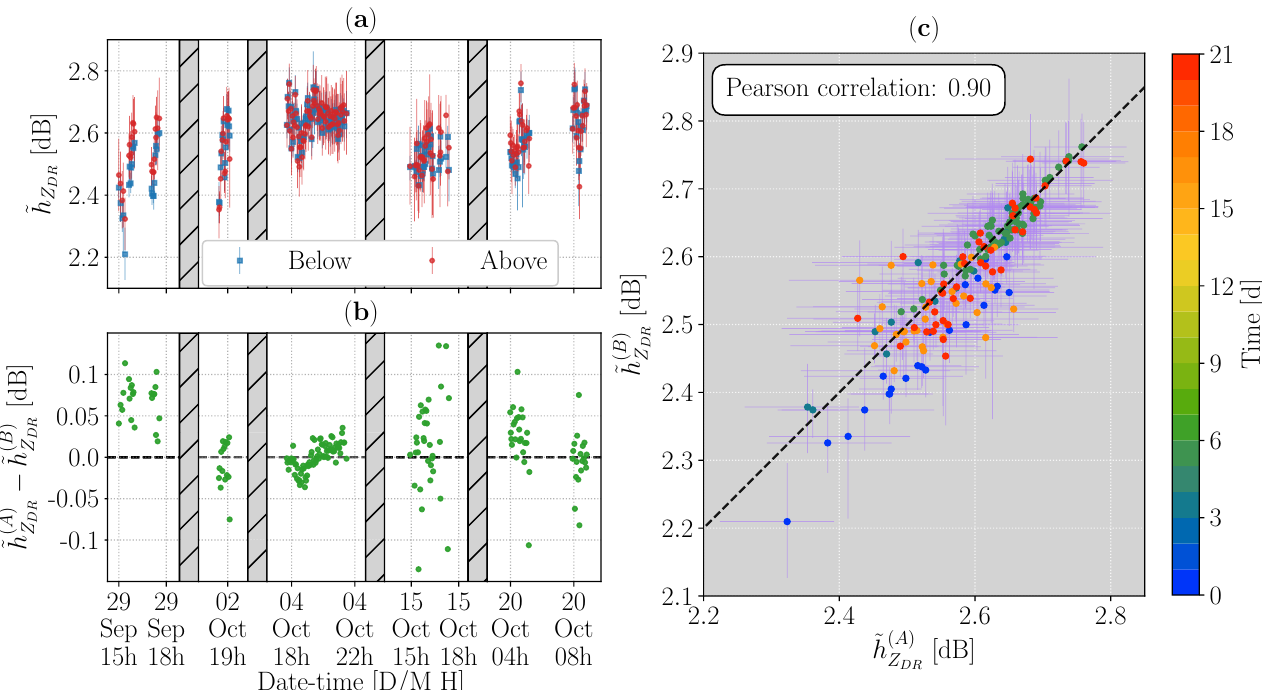
Figure 3. Comparison of median differential reflectivity values below and above the melting layer for the HYMEX campaign. ( B ) ( t ) (in blue) and ˜ h ( A ) ( t ) (in red), covering 5 precipitation events. The vertical bars around each ( a ) Time series of ˜ h i , u i , u Z DR Z DR dot represent the interquartile range of the distribution of Z DR values in the selected region of the scan. ( b ) Difference ˜ h ( A ) ˜ h ( B ) ( t ) ( t ) . The x-axis is shared with panel ( a ); ( c ) Scatterplot of ˜ h ( A ) i , u i , u Z DR Z DR − and horizontal bars representing the same interquantile range depicted in panel ( a ). The color assigned to each dot shows the number of days passed since the beginning of the time series considered, to highlight how the agreement remains consistent for the five precipitation events (between 29th September and 20th October